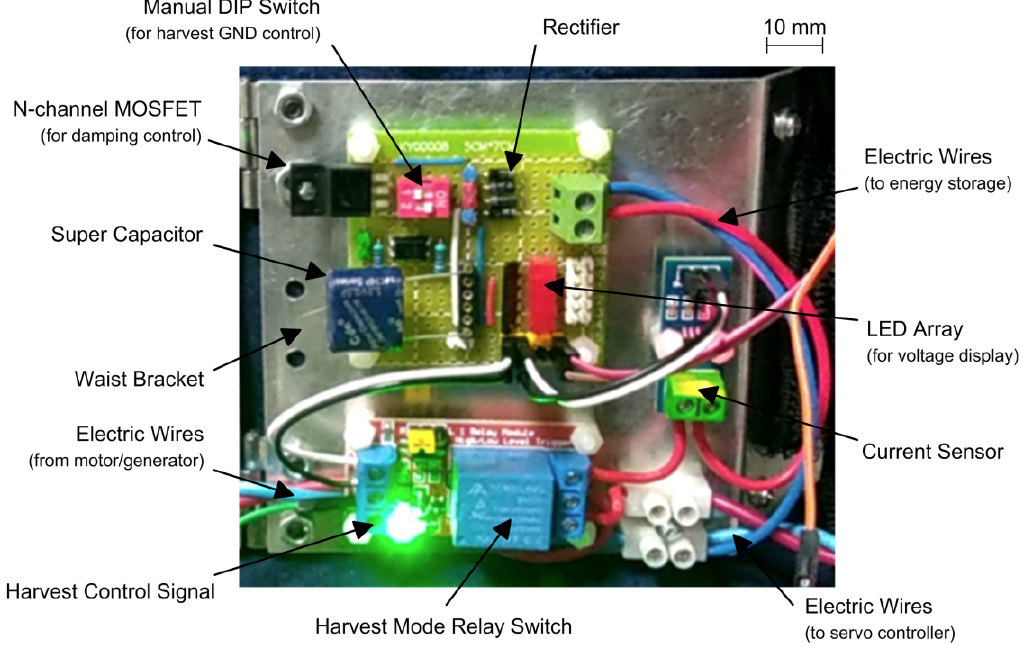
Table 2. Geometric dimensions of the major components in the energy harvesting module.